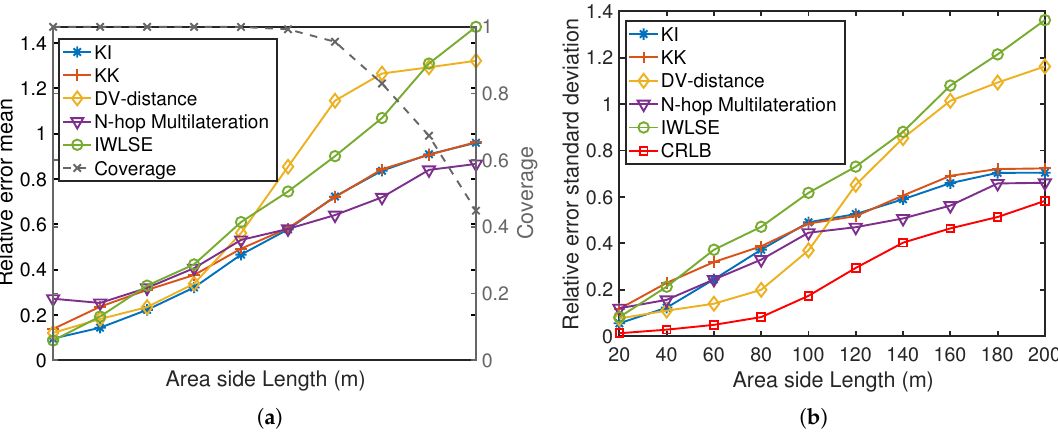
Figure 10. ( a ) Average estimation error and coverage, ( b ) SD as a result of changing the area size. Transmission range: if we increase the transmission range of the transceivers, the number of neighbors in the network is increasing, but the distance measurement error also increases, which results in a trade-off between the benefit from more distance information and the shortcomings of highly noisy distance information. Figure 11 illustrates that both the DV-based distance correction used in DV-distance and IWLSE, and leveraging the precision of measurements in KickLoc algorithms and IWLSE can effectively mitigate the highly noisy distance information. When the transmission range is very large, N-hop Multilateration works poorly as it does not have a strategy to alleviate the noisy distance measurement. Note that KK also works poorly with the high measurement error, which is due to the large linearization error in this